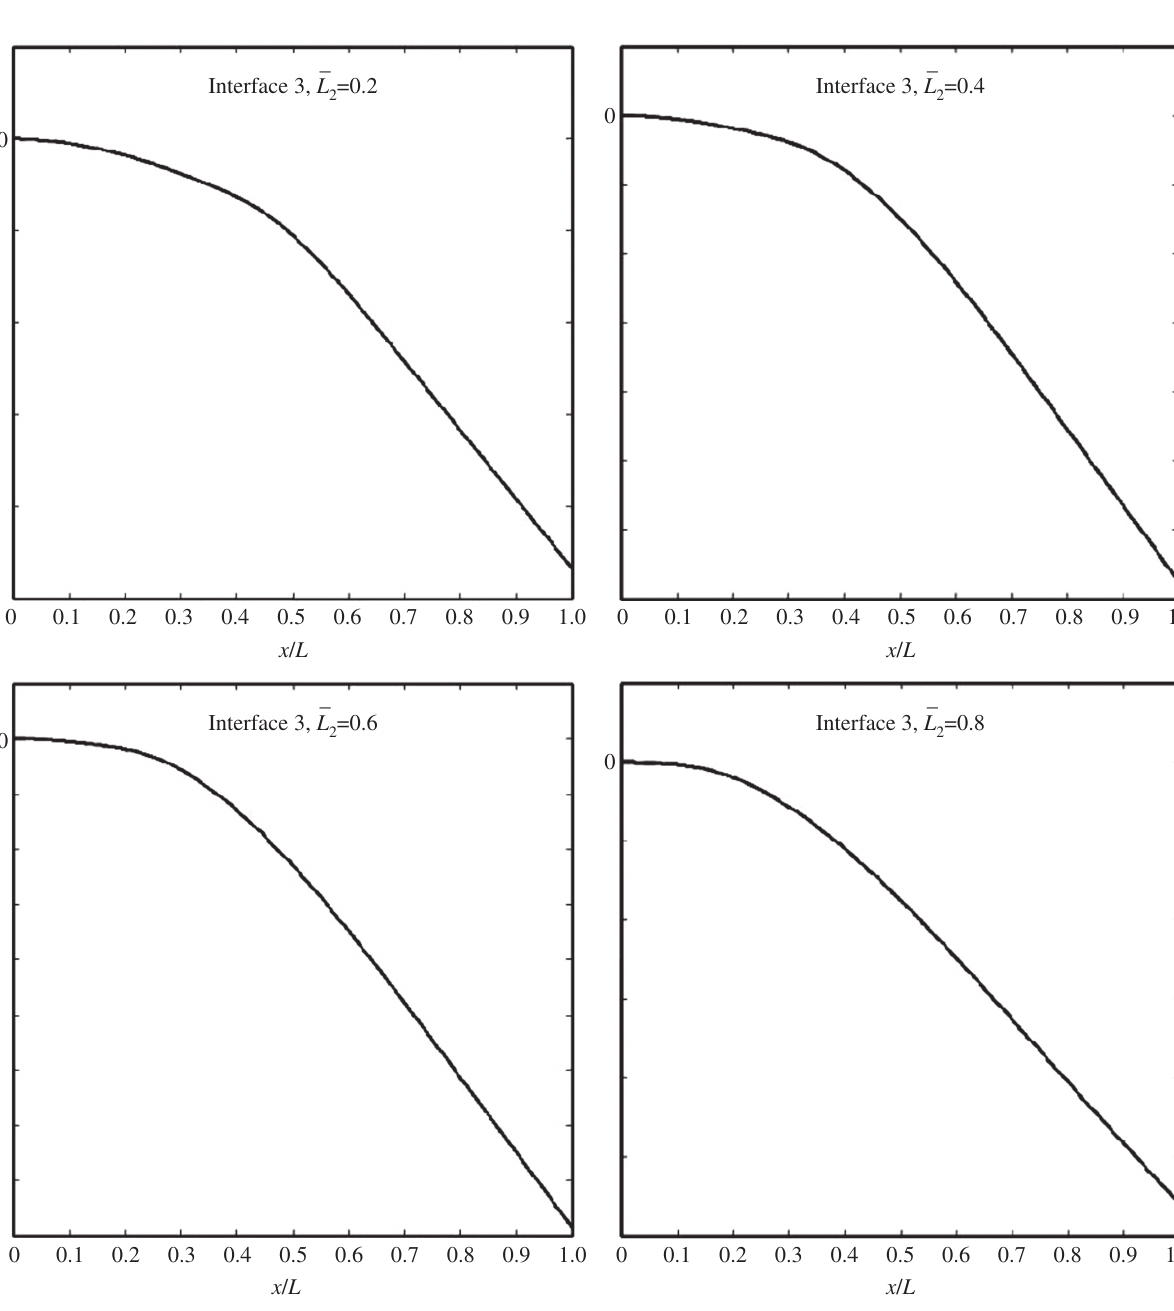
Lower and upper bounds of the natural frequencies are obtained out of solutions for the free and constrained modes of the delaminated layers, respectively, as pointed out in section